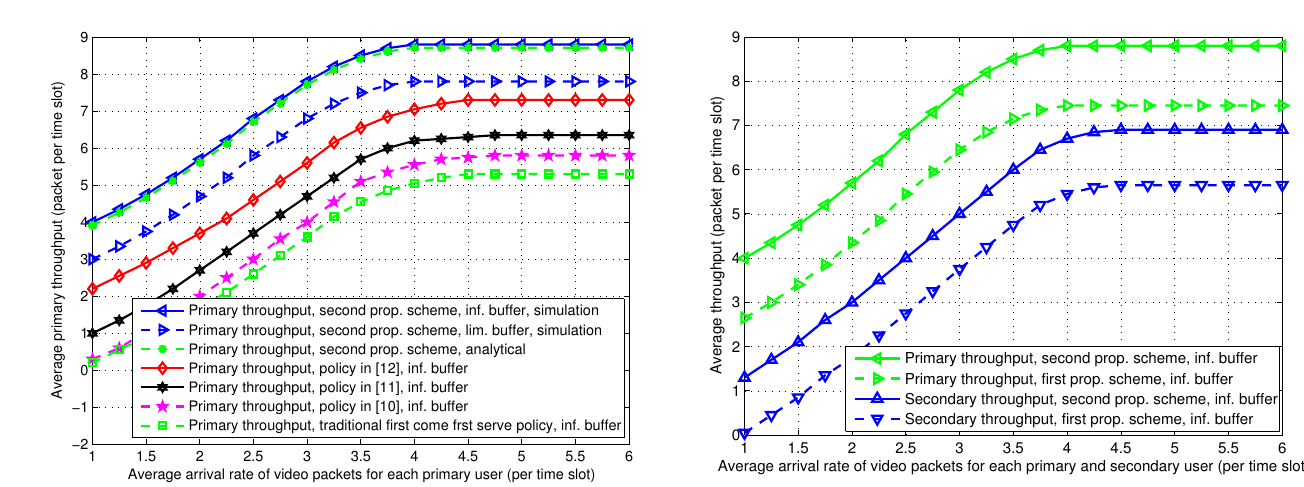
Figure 8. Comparison of the average throughput in the first and second proposed schemes.